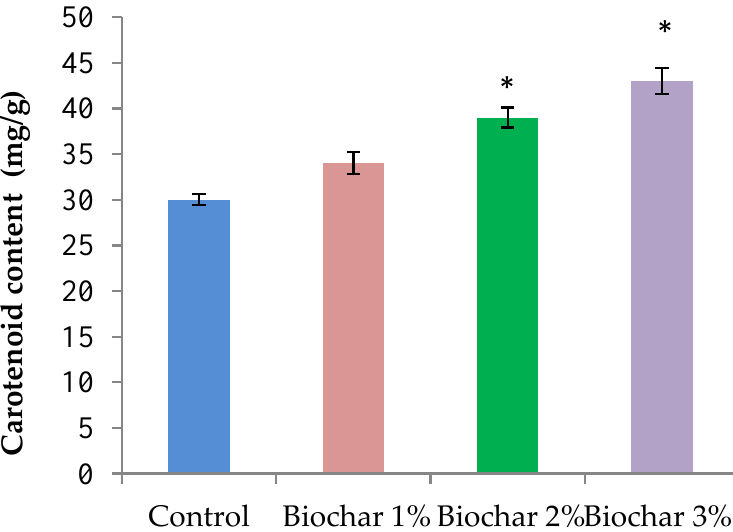
Figure 5. The impact of biochar concentrations on carotenoid content of ginger. Data are means of three replicates ( n = 3), asterisks indicate significant differences from the control at p < 0.05.